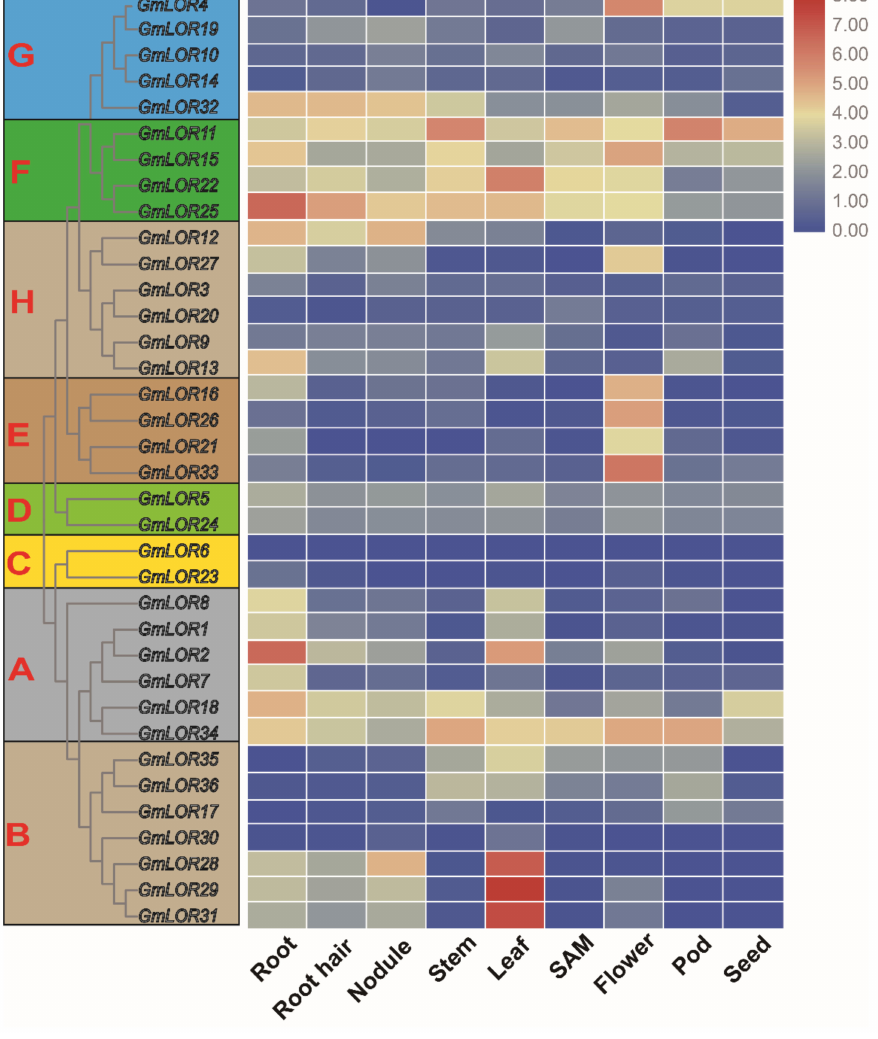
Figure 6. Expression profile of 36 GmLOR genes in different tissues of soybean. FPKM values of GmLOR genes were obtained from Phytozome v12 and were transformed by log2. Different colors in the heat map represent gene transcript abundance values, as shown in the bar at the top of